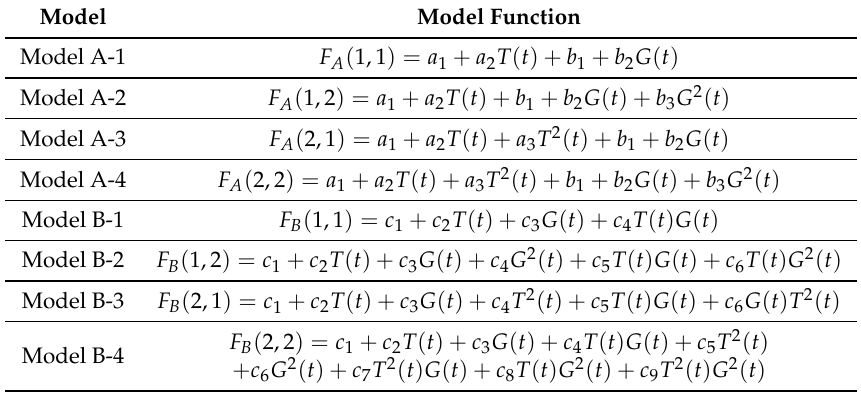
Table 2. Proposed polynomial models for additive F A and multiplicative F B